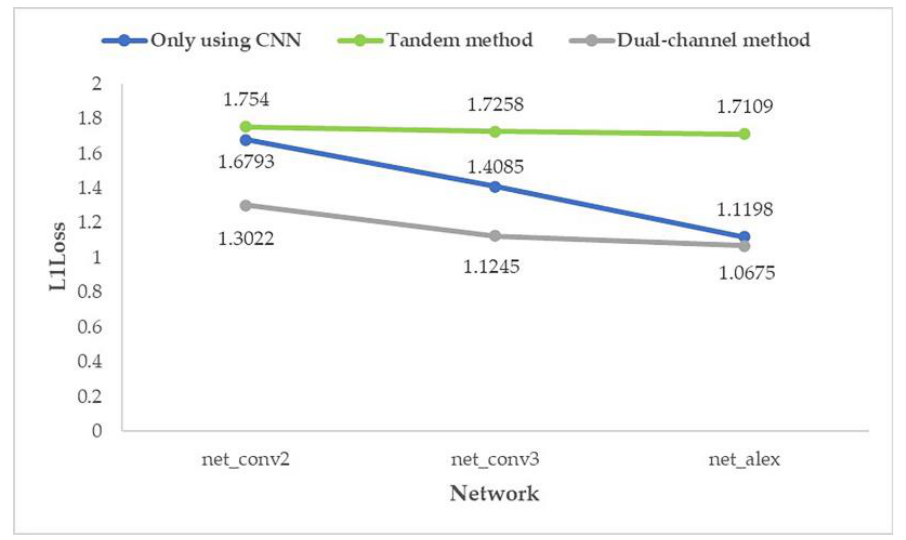
Figure 18. Average prediction loss of five parameters with random seed 0.